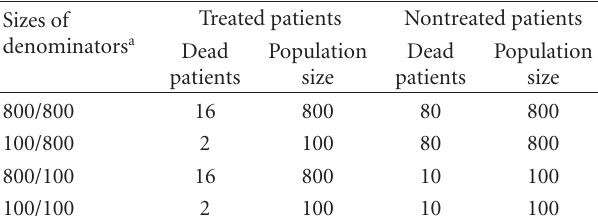
Figure 4: Percentage of participants whose estimates of risk reduction were accurate, as a function of graph literacy, icon arrays, and sizes of the denominators. Error bars represent one standard error. Table 2: Number of treated and nontreated patients who died from a heart attack used in fictitious medical